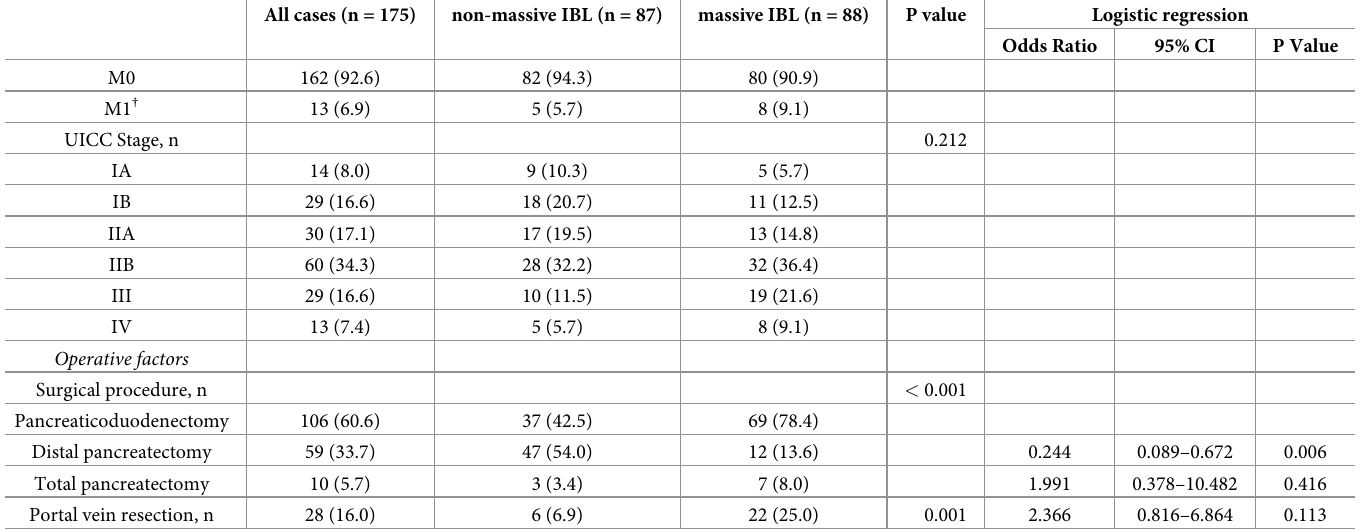
Table 4. Comparison of the operative outcomes of the massive IBL and non-massive IBL groups.